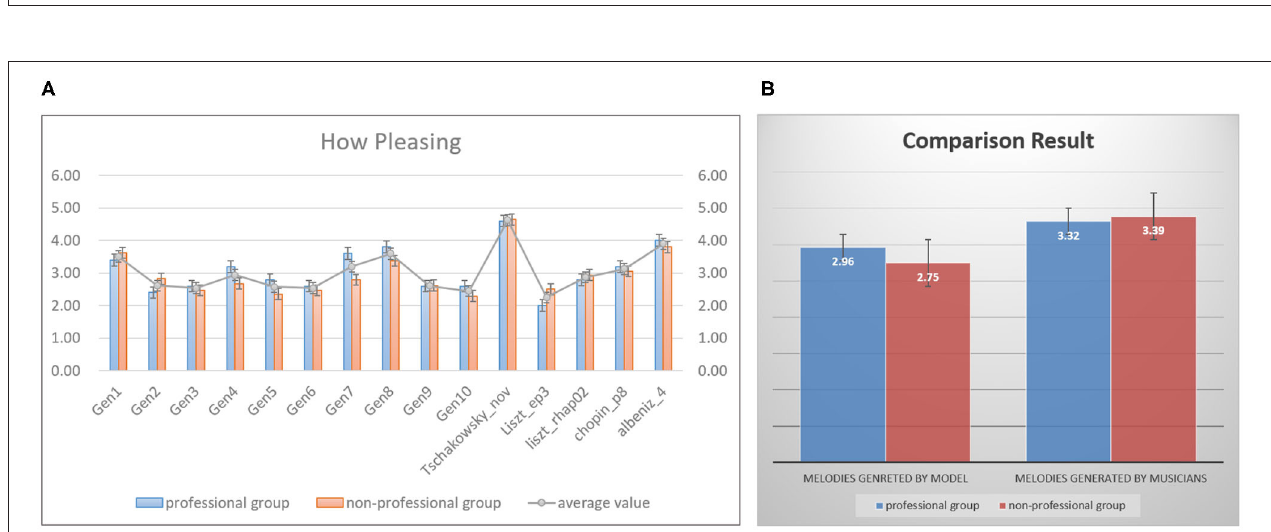
FIGURE 12 | The encoding results of the Mozart’s famous work “Sonate C Major, K545.” (A) Shows the firing results of neurons in pitch subnetwork, the vertival axis presents the pitch index that the neuron prefers, the horizontal axis presents the time. (B) Exhibits the activities of neurons in duration subnetwork, the vertical axis is the duration(ticks defined in MIDI standard) which the neuron prefers, the horizontal axis indicates the time.